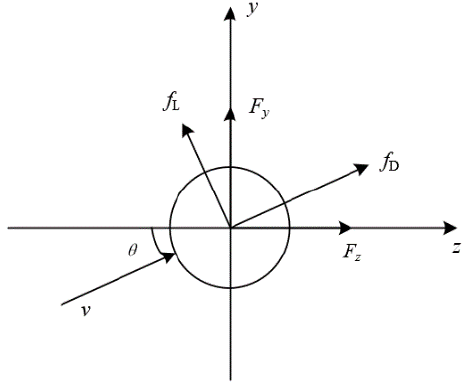
Fig. 4. Aerodynamic force of positive feeder